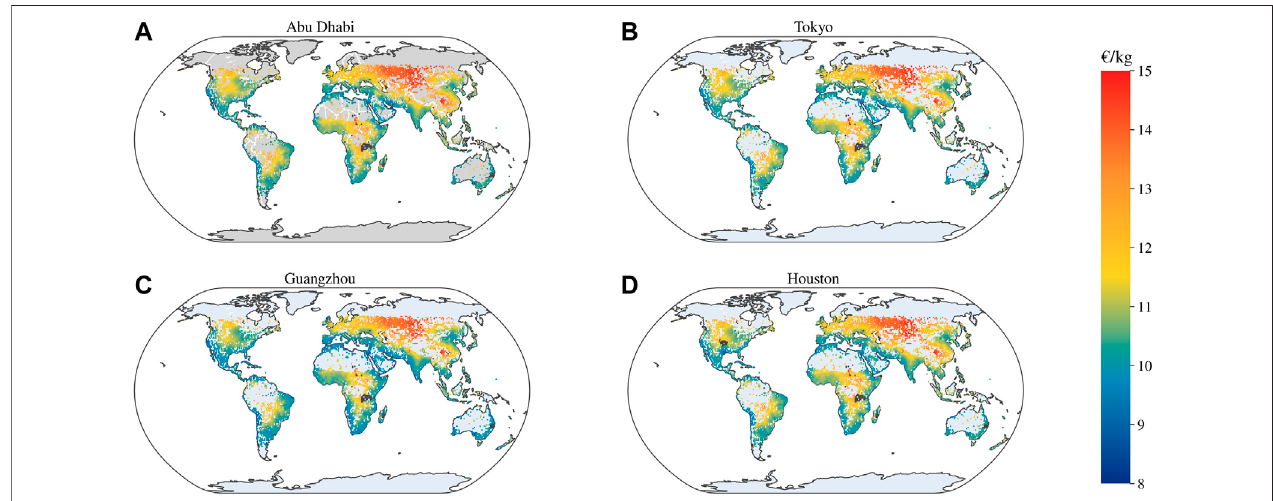
FIGURE9| Thetotal(delivered)costperkgofproducingandtransportingH 2 toAbuDhabi (A) ,Tokyo (B) ,Guangzhou (C) ,andHouston (D) ,fromeachofthe5970 selected global locations. Black dots represent locations where possible transport routes could not be found. The rest of the parameters remain the same as for the baseline scenario (100 kt/y AE electrolyser in 2030). Results are from a Monte Carlo simulation with 1,000